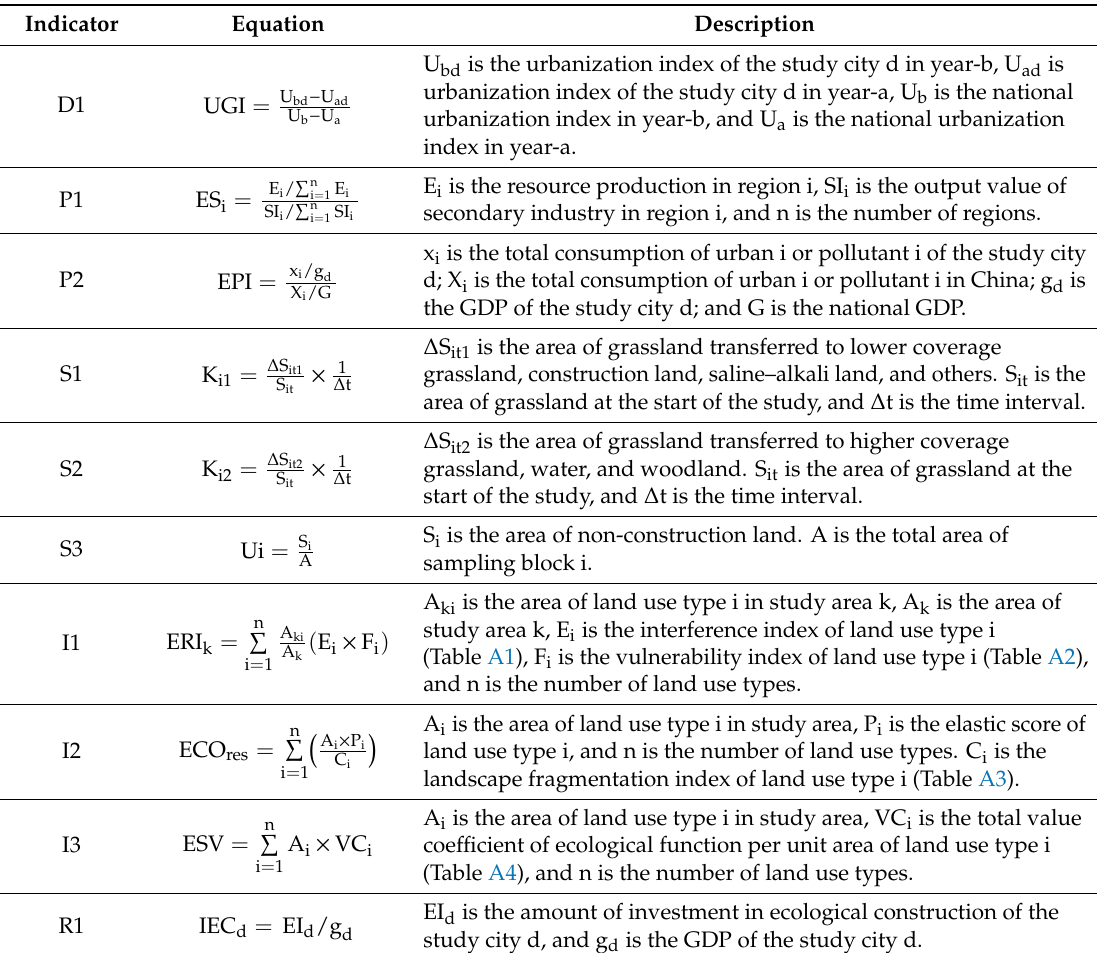
Table 5. Index computing method for landscape ecological security